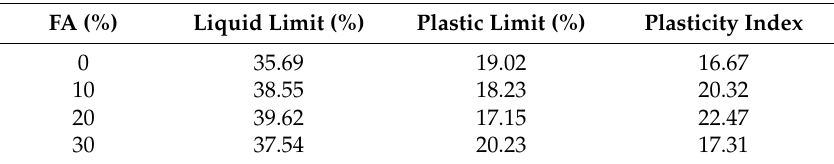
Table 5. The effects of the addition of various FA